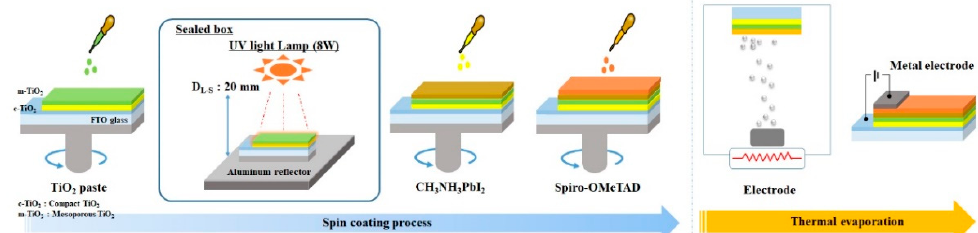
Figure 1. Schematics of the perovskite solar cell (PSC) fabrication procedure with ultraviolet (UV) light treatment ( D L-S = distance from light to sample ).